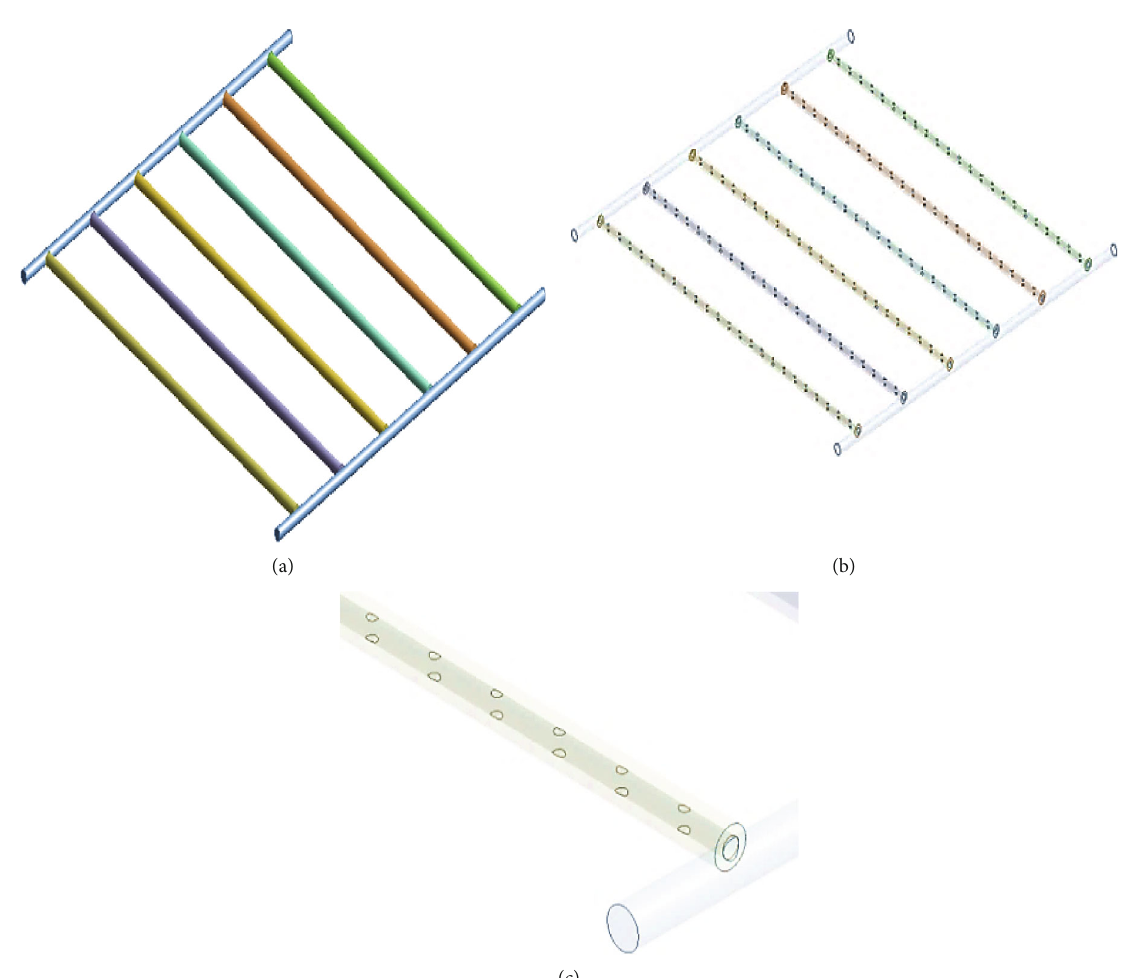
Figure 3: (a) Plain tube. (b) Dimpled tube. (c) Dimpled tube with nano fl